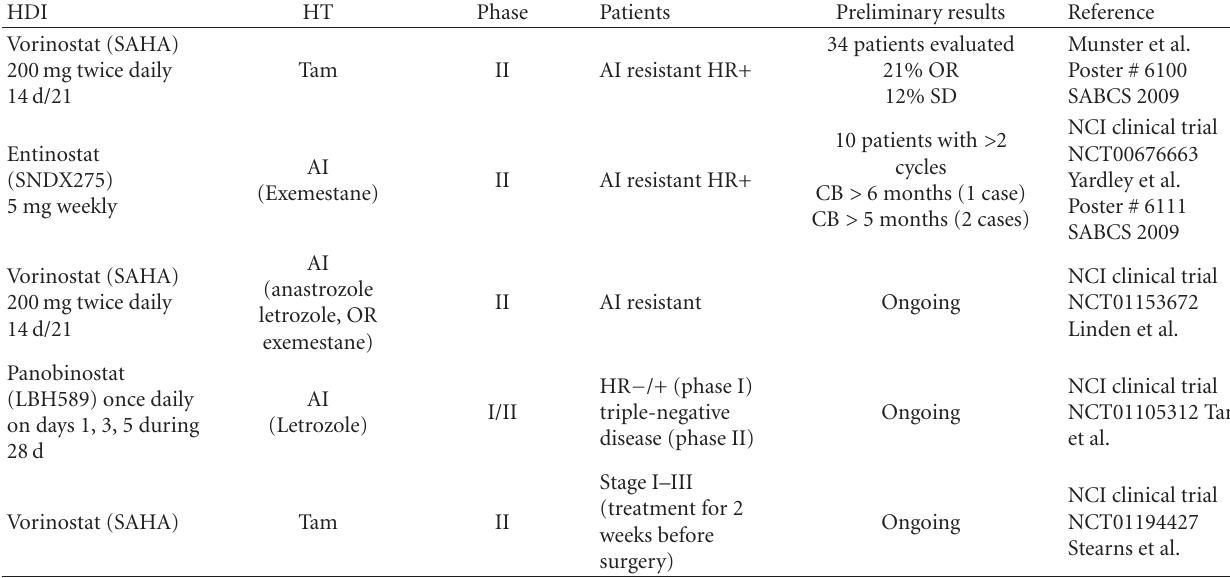
Table 4: Clinical trials combining HDI and HT in advanced/metastatic ER-positive breast